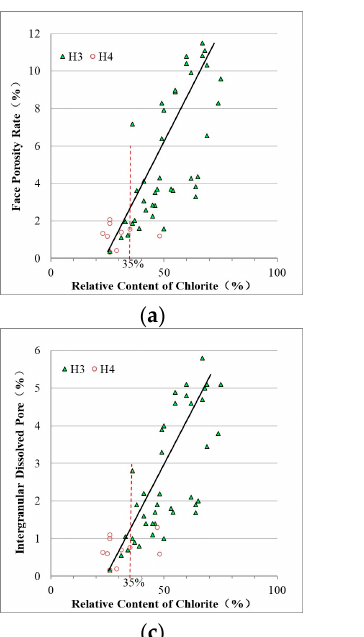
Figure 11. The pore-lining chlorite with chlorite to protect the mold holes (backscatter scanning electron microscopy). (3) Protect the primary pore, promote the development of secondary intergranular dissolved pores: The development of the pore-lining chlorite can effectively protect the primary pores. Statistics show that the chlorite content is in proportion to the primary pore (Figure 12b); at the same time, the reservoir with the pore-lining chlorite maintains an open fluid field, which is conducive to the invasion of organic acids and ion removal after dissolution, and promotes the development of secondary intergranular dissolution pores. The main reason for the difference in petrophysical properties of H3 and H4 is as follows: when chlorite > 35%, face porosity rate > 2%. Some primary pores were retained, and intergranular pores were developed (Figure 12).